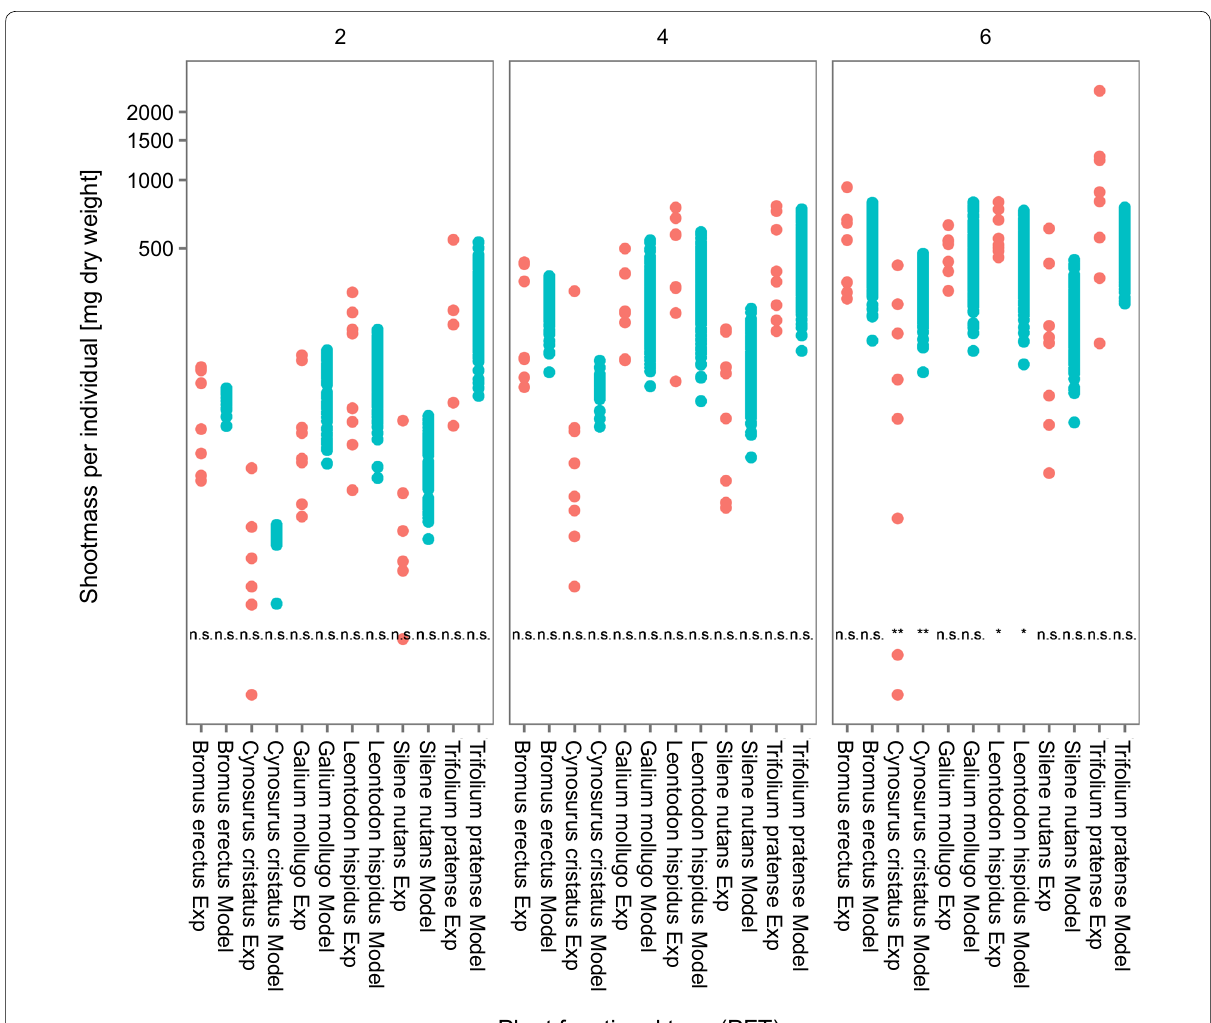
Fig. 2 Model calibration to empirical monocultures: Comparing the shoot weight of experimentally measured (red points, N (blue points, N 900 covering potential variability in resource levels) data for each assessment date in control monocultures. Experimental values = measured in fresh weight were converted to dry weight using a conversion factor based on a repeated monoculture control experiment, in which we measured the fresh to dry weight ratio of each species (see Additional file 1: Appendix B for further details). Both broad spectrum herbicide and selective herbicide control values are included in the experimental data. Each experiment model pair was tested for significance using a t test; not significant results indicate that there are no differences between experimental and model data. Please note the logarithmic scale of the y